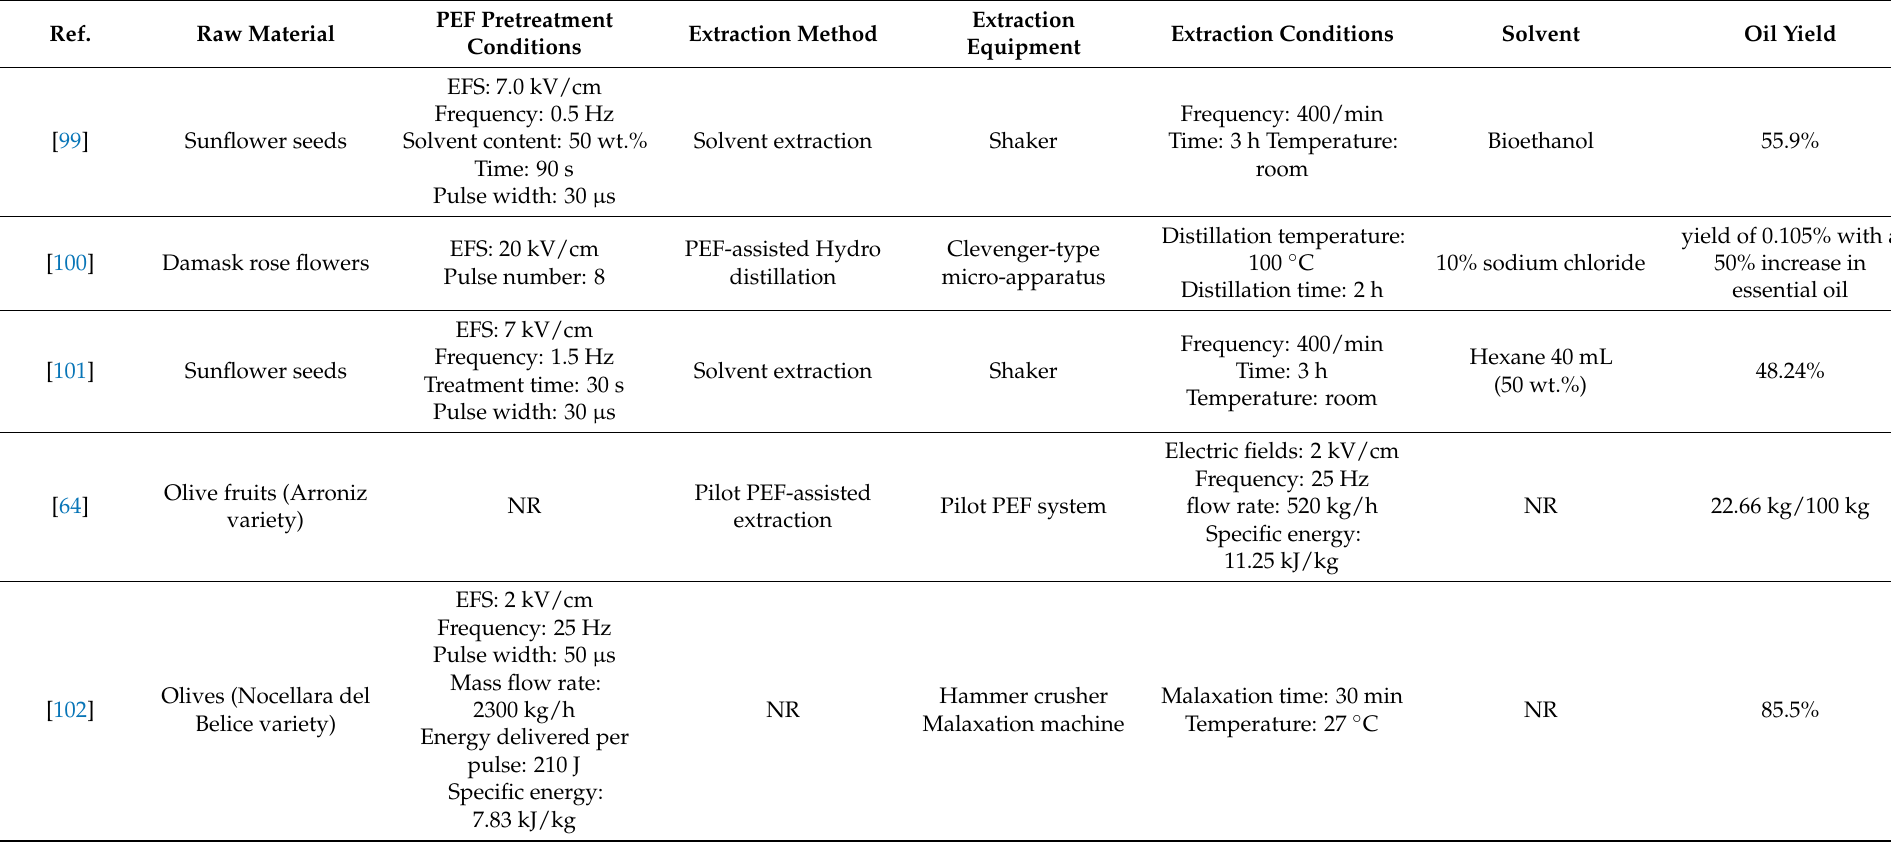
Table 3. PEF assisted extraction of